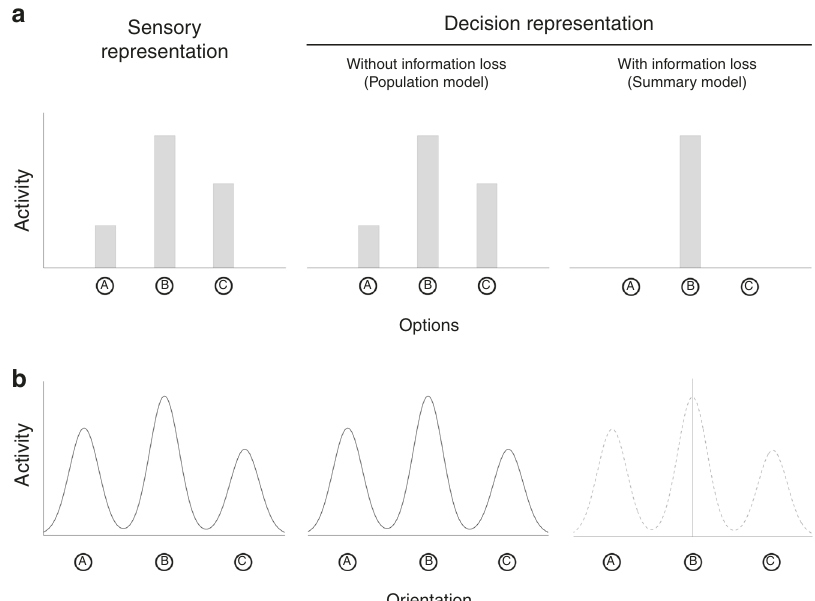
Fig. 1 Sensory and decision-level representations for multiple alternatives. a Illustration of decision making with multiple discrete alternatives. In cases where a subject has to choose between multiple discrete alternatives (e.g., options A, B, and C), a stimulus can be assumed to give rise to a sensory representation that consists of different amount of sensory activity for each alternative (left panel). A decision-level representation without information loss would consist of a copy for the sensory representation (middle panel). We refer to this possibility as a population model of decision-level representation. On the other hand, the decision-level representation may consist of only a summary of the sensory representation thus incurring information loss. One possible summary representation consists of passing only the highest activity onto decision-making circuits (right panel). We refer to this type of representation as a summary model of decision-level representation. This summary representation involves information loss that will become apparent if subjects have to choose between the other alternatives (e.g., alternatives A and C). b Decision making with a continuous but multimodal sensory representation. Similar to having multiple discrete alternatives, decisions can involve judging a continuous feature (e.g., orientation) but in the context of a multimodal (e.g., a trimodal) underlying sensory representation (left panel). The decision-level representation can again consist of either a copy for the sensory representation (middle panel) or a summary of this sensory representation (right panel).